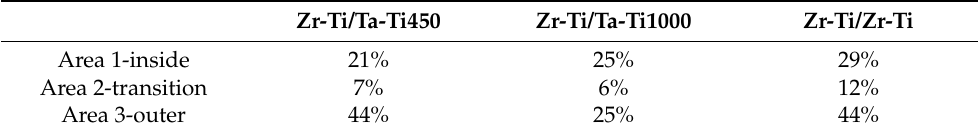
Table 2. The volume fraction of particular areas of all